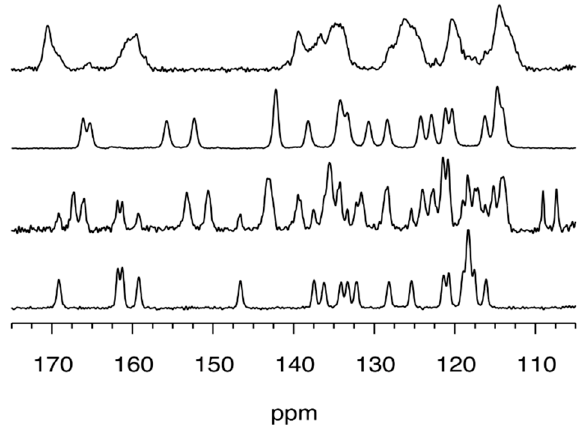
Figure 4. 13 C solid-state NMR spectra (105–175 ppm region) recorded at 11.7 T, and room temperature of mechanosynthesized ligand 1 and of the corresponding metal–salophen complexes (from bottom to top: compound 1 , 1Pd , 1Ni , 1Zn ).